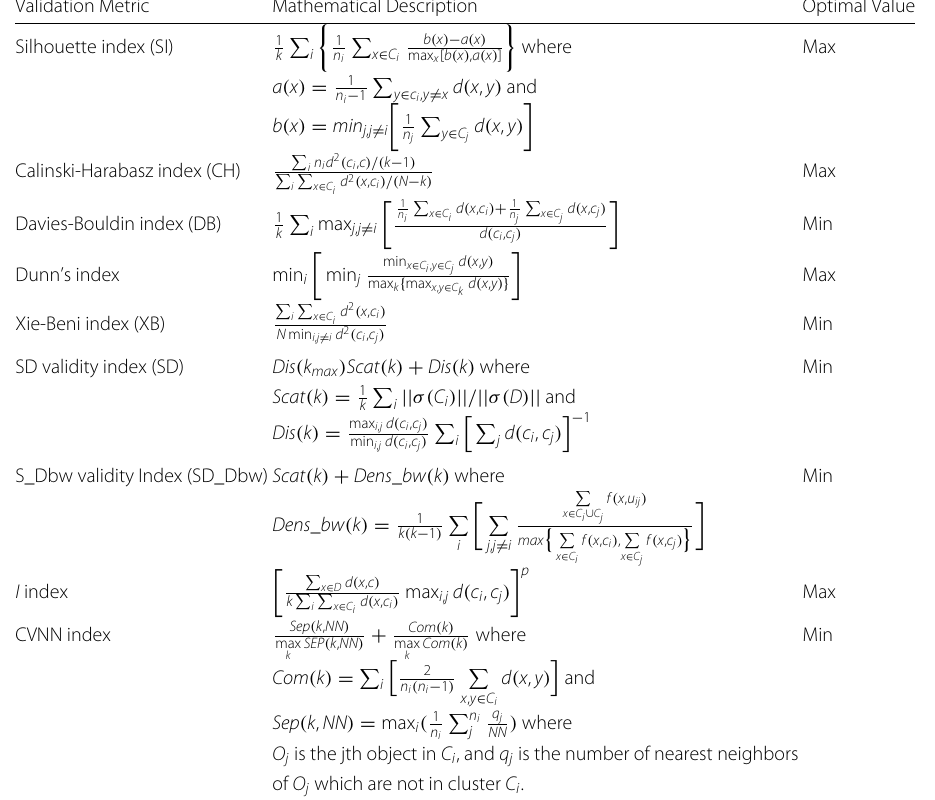
Table 1 Summary of internal cluster validation used to determine optimal clustering configuration Validation Metric Mathematical